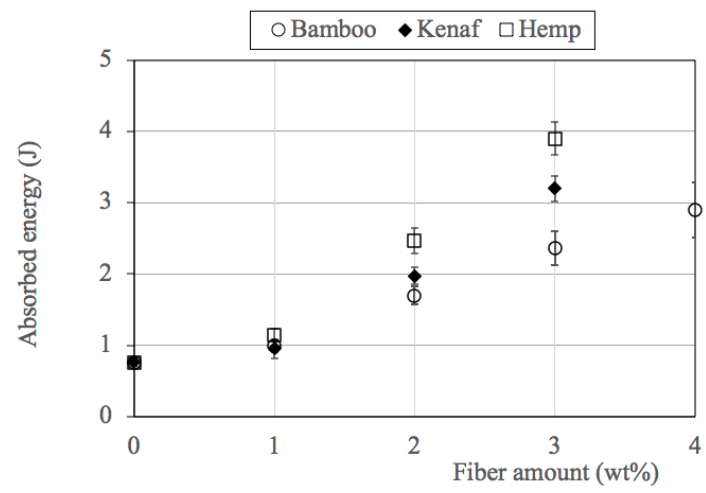
Figure 8. Absorbed energy for the different composites during the flexural test.